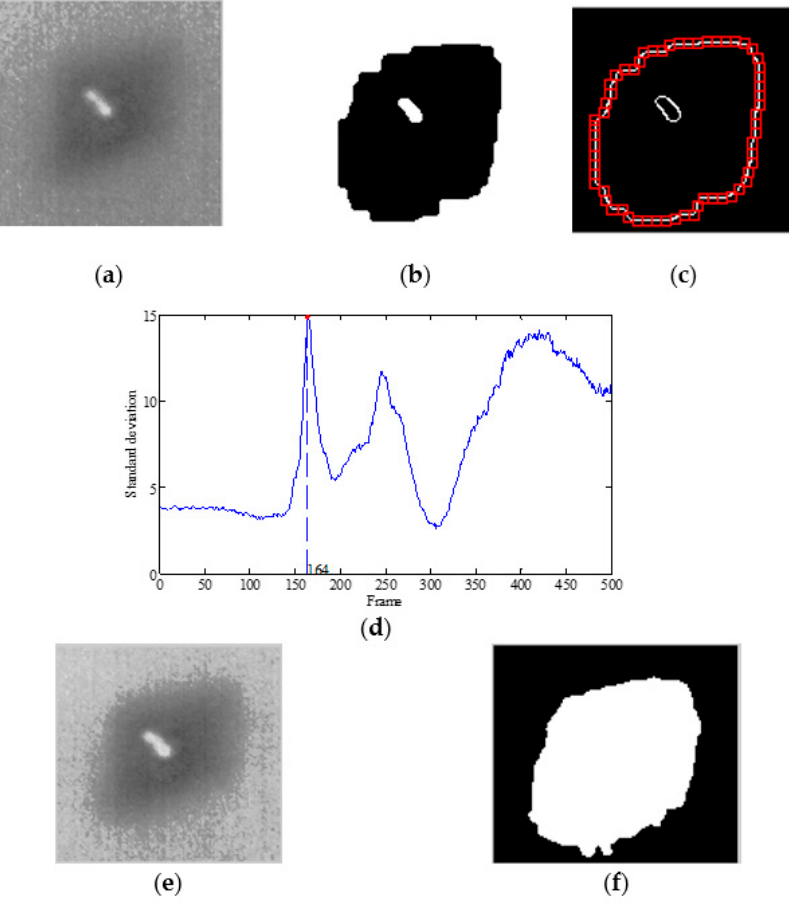
Figure 31. Delamination defect extracted by MSDSRM: ( a ) ROI of Frame 150; ( b ) Binary image; ( c ) Sensitive areas selected; ( d ) Curves of standard deviation vs. time based on random selection of sensitive regions; ( e ) ROI of Frame 164; ( f ) Defect segmentation.